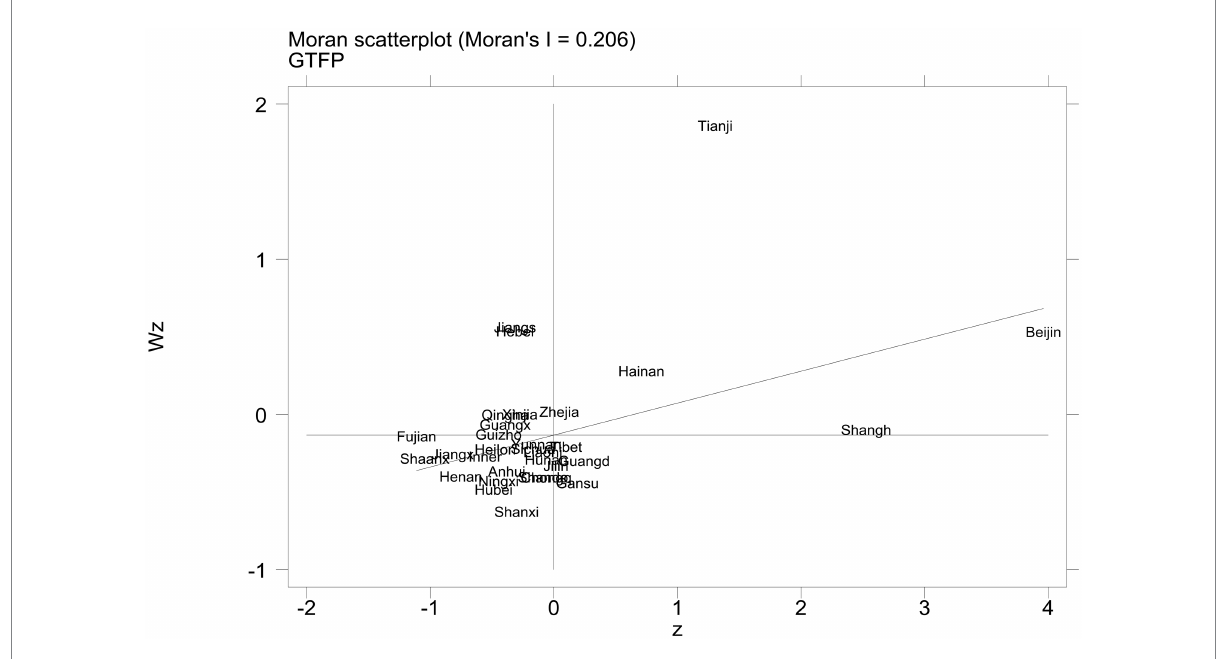
FIGURE 3 Distribution of Moran index in 31 provinces and cities.